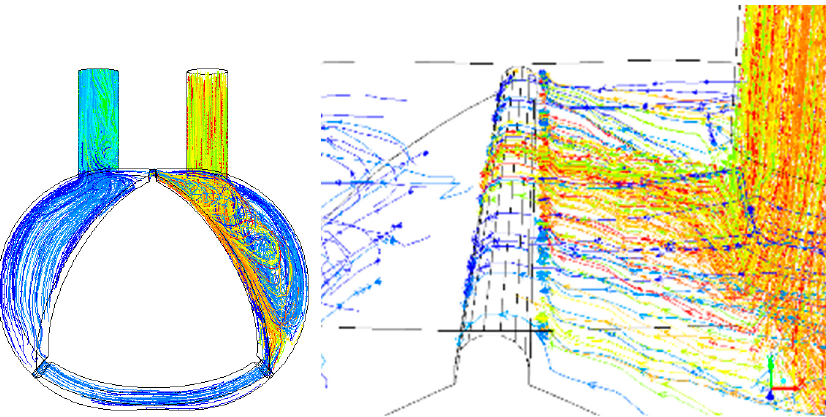
Figure 17. Stream lines showing leakages at the apex seal (Hsieh et al. [66]).